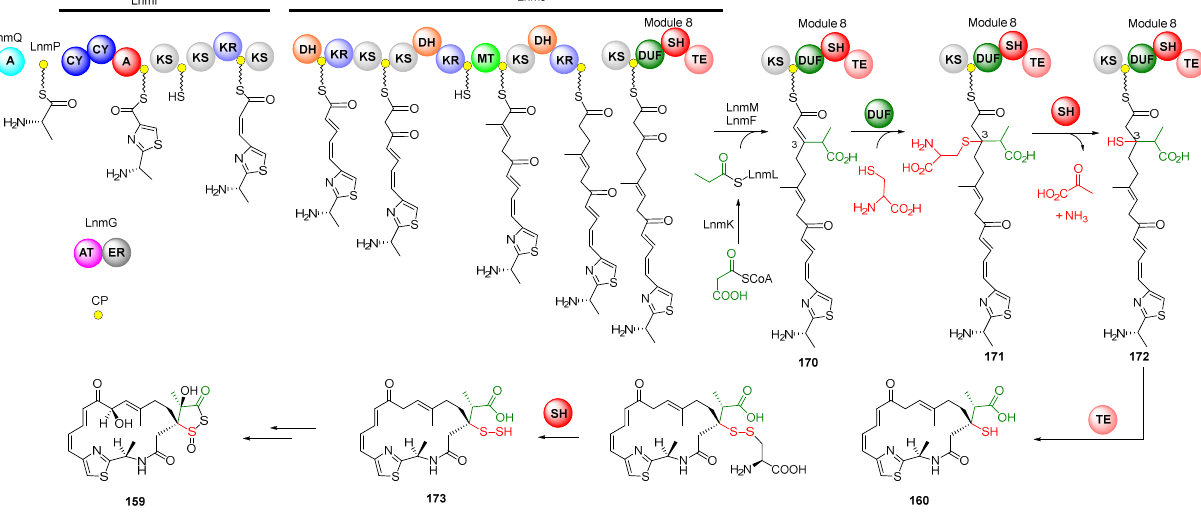
Figure 22. Proposed biosynthetic pathway of leinamycin. CP, carrier protein; CY, condensation/cyclization; MT, transferase; ER, enoyl reductase; TE, thioesterase; DUF, the domain of unknown function; SH, PLP-dependent cysteine lyase domain.